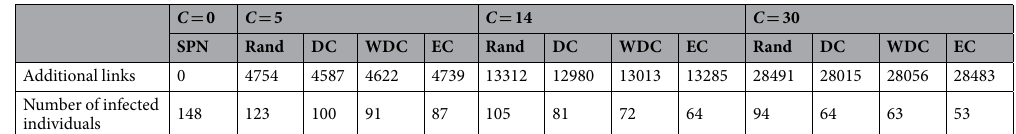
Table 5. Mean number of infected individuals in the long run under each selection strategy –Random, Degree Centrality, Weighted Degree Centrality, and Eigenvector Centrality– and the corresponding number of additional links with respect to the standard partner notification (SPN) network for the chosen values of selected nodes C = (5, 14, 30).